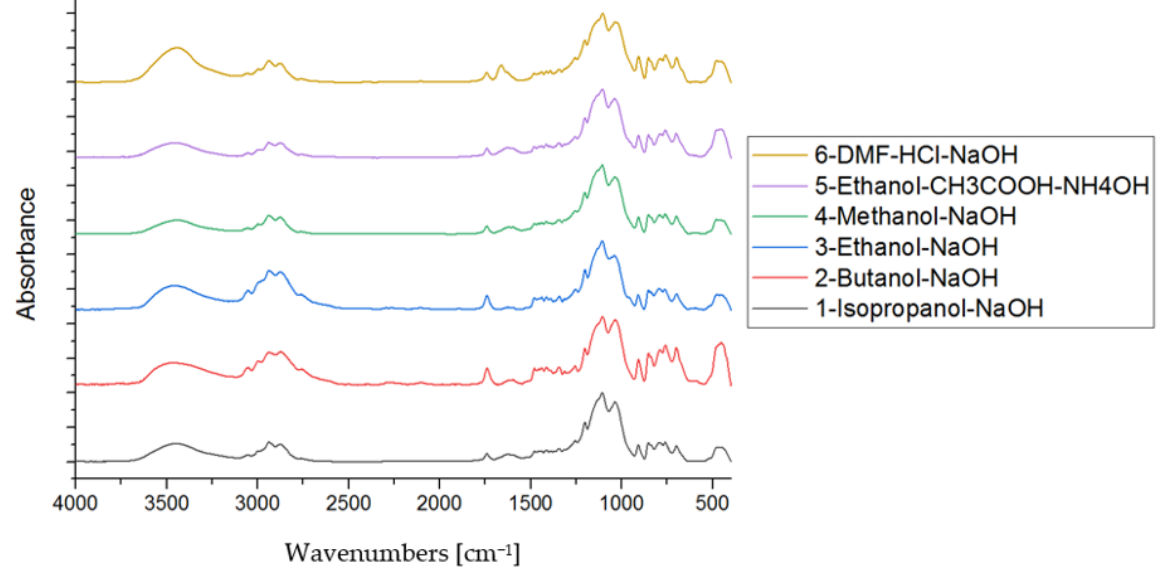
Figure 5. Normalized FTIR spectra of hybrid